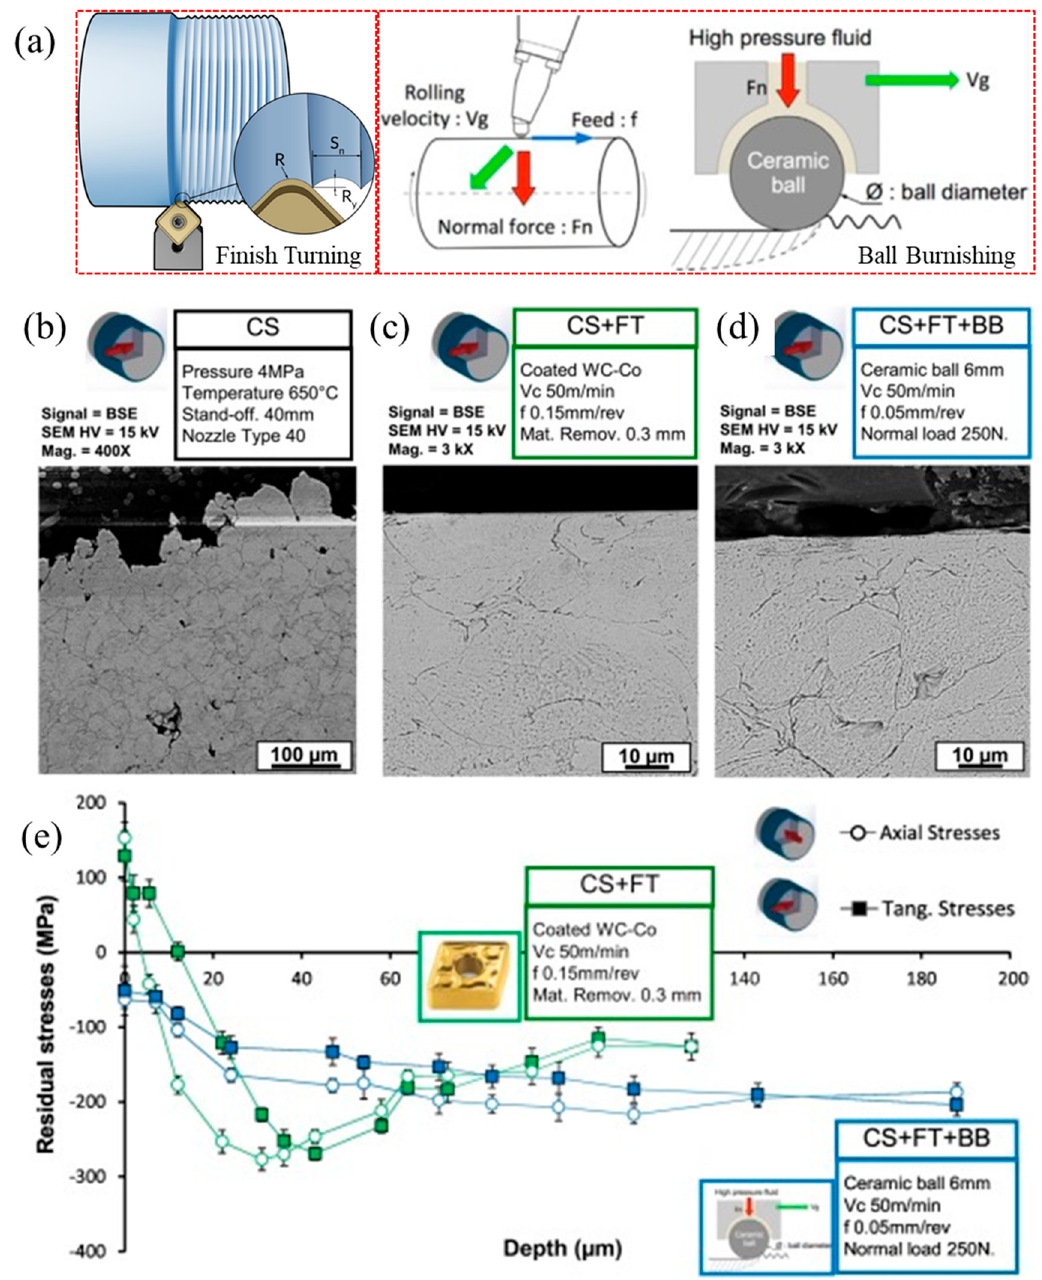
Figure 22. ( a ) Schematic diagram of finish turning and ball burnishing processes, ( b – d ) SEM images of ( b ) as-cold sprayed 17-4PH stainless steel coating, ( c ) cold sprayed 17-4PH stainless steel coating